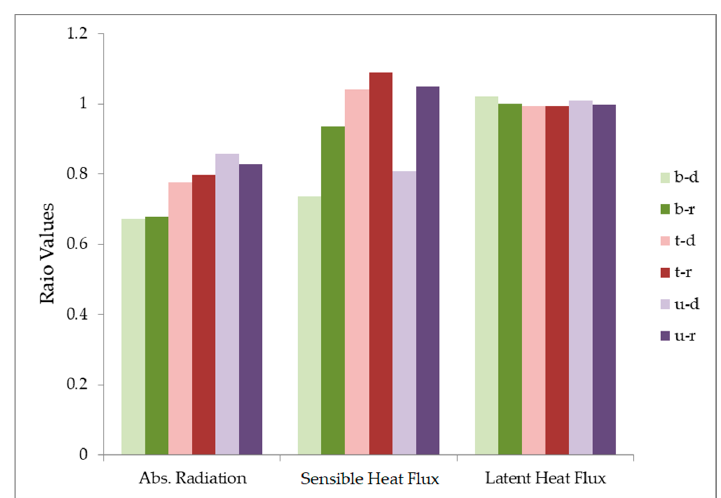
Figure 6. Median ratio values of the various components of the energy budget caused by a strategy.